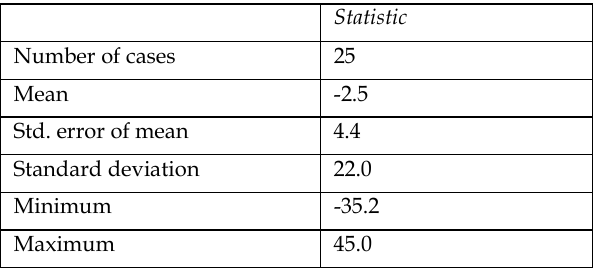
Table 1. Summary statistics for forecast inaccuracies for toll